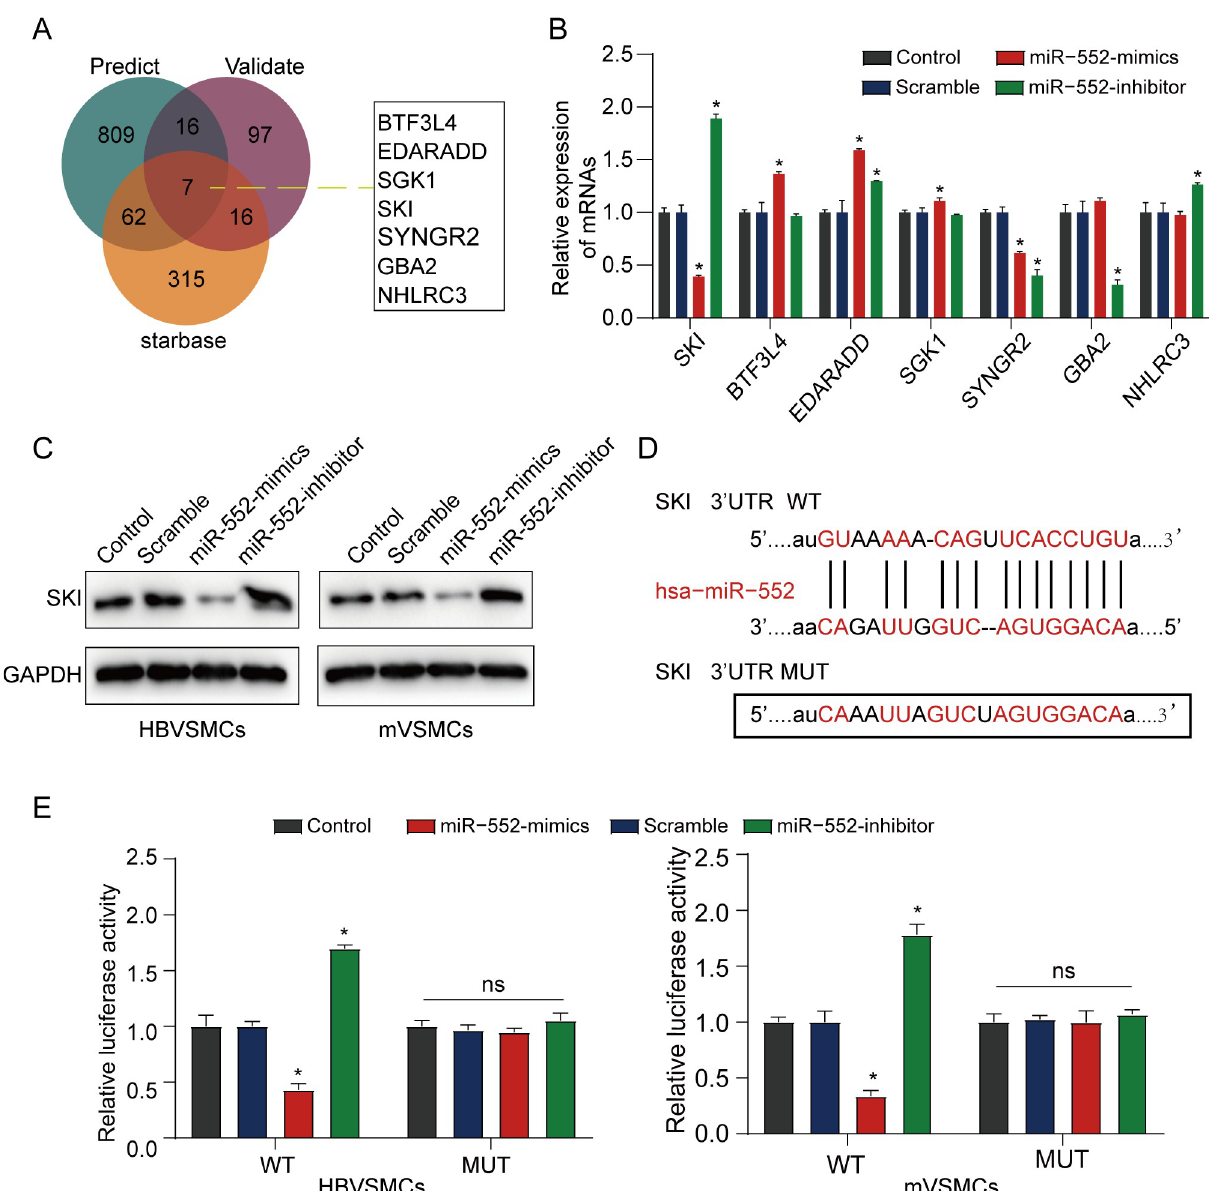
Fig 3. MiR-552 targets SKI in HBVSMCs. (A) Venn diagram among miRWalk predicted, miRWalk validated and Starbase sets. ( B ) qRT-PCR analysis for the determined seven DEGs in HBVSMCs treated with PDGF-bb. ( C ) Western blot assay was used to detect the protein level of SKI in VSMCs (HBVSMCs and mVSMCs) when they were transfected with miR-552 mimics, inhibitor, scramble or control, respectively. ( D ) Bioinformatics analysis predicted putative miR-552 target sites of SKI 3’UTR. ( E ) VSMCs (HBVSMCs and mVSMCs) were co-transfected with SKI-WT or SKI-MUT and miR- 552 mimics or miR-NC mimics, after 48 h following transfection, luciferase activities were detected. (Student’s t test). � P < 0.05. ns: No